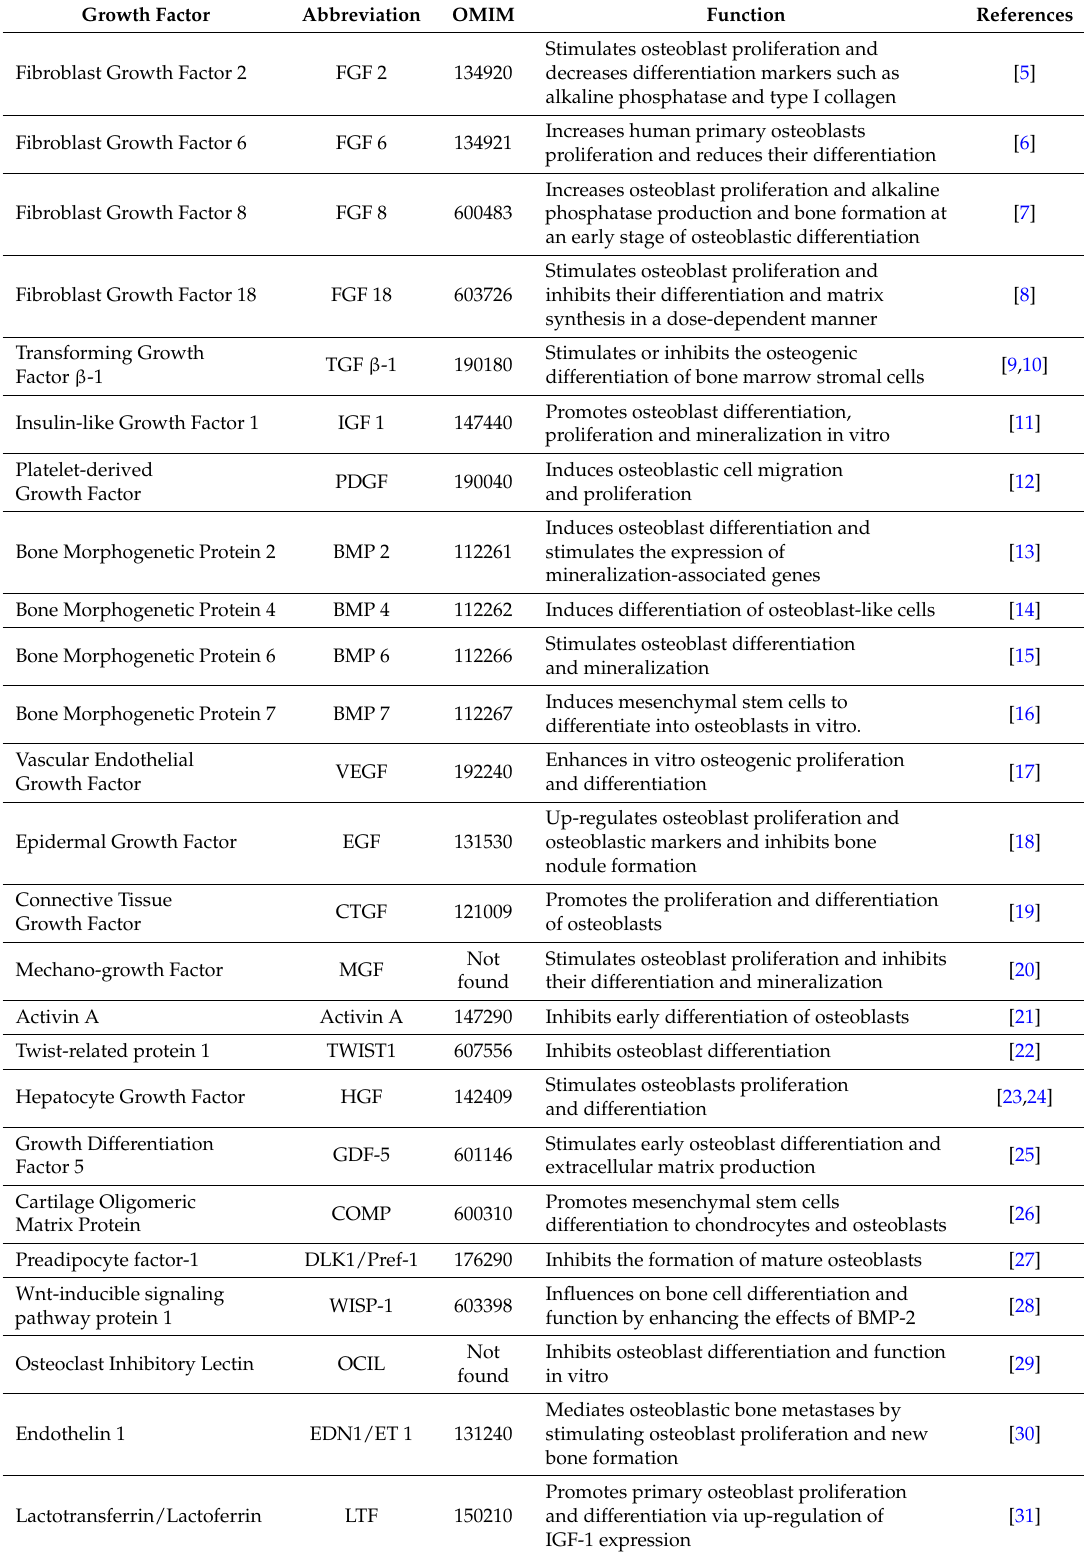
Table 1. Growth factors associated with osteoblast